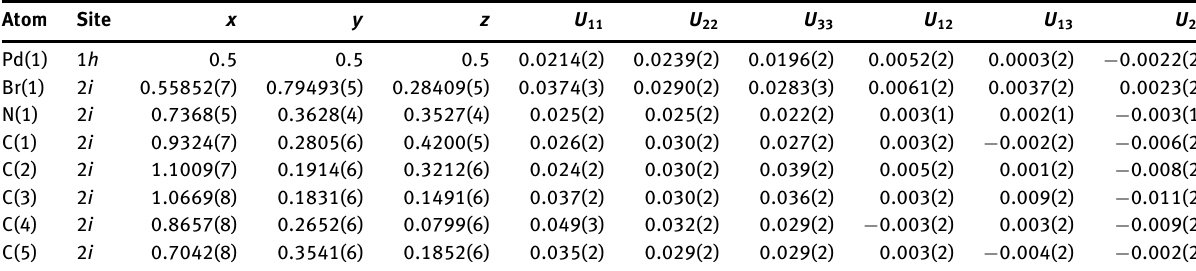
Table 3: Atomic coordinates and displacement parameters (Å 2